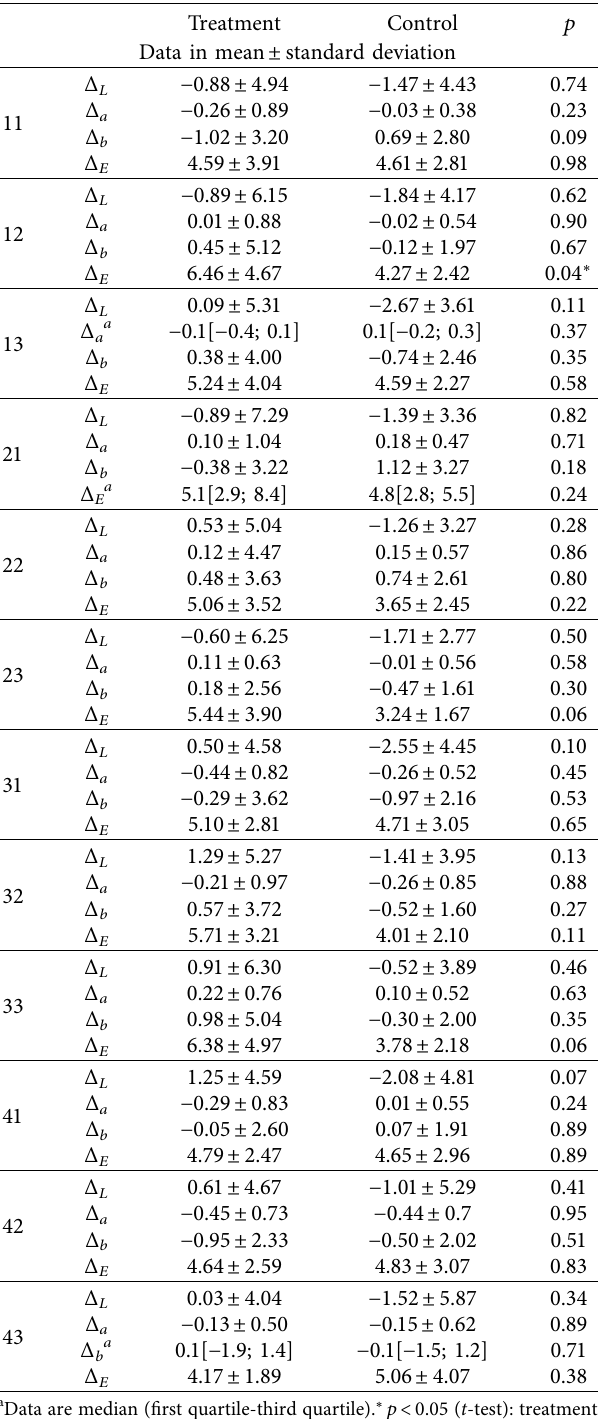
Table 4: L ∗ , a ∗ , b ∗ , and Δ E values for each tooth of the treatment group ( n � 19) and the control group ( n � 19).